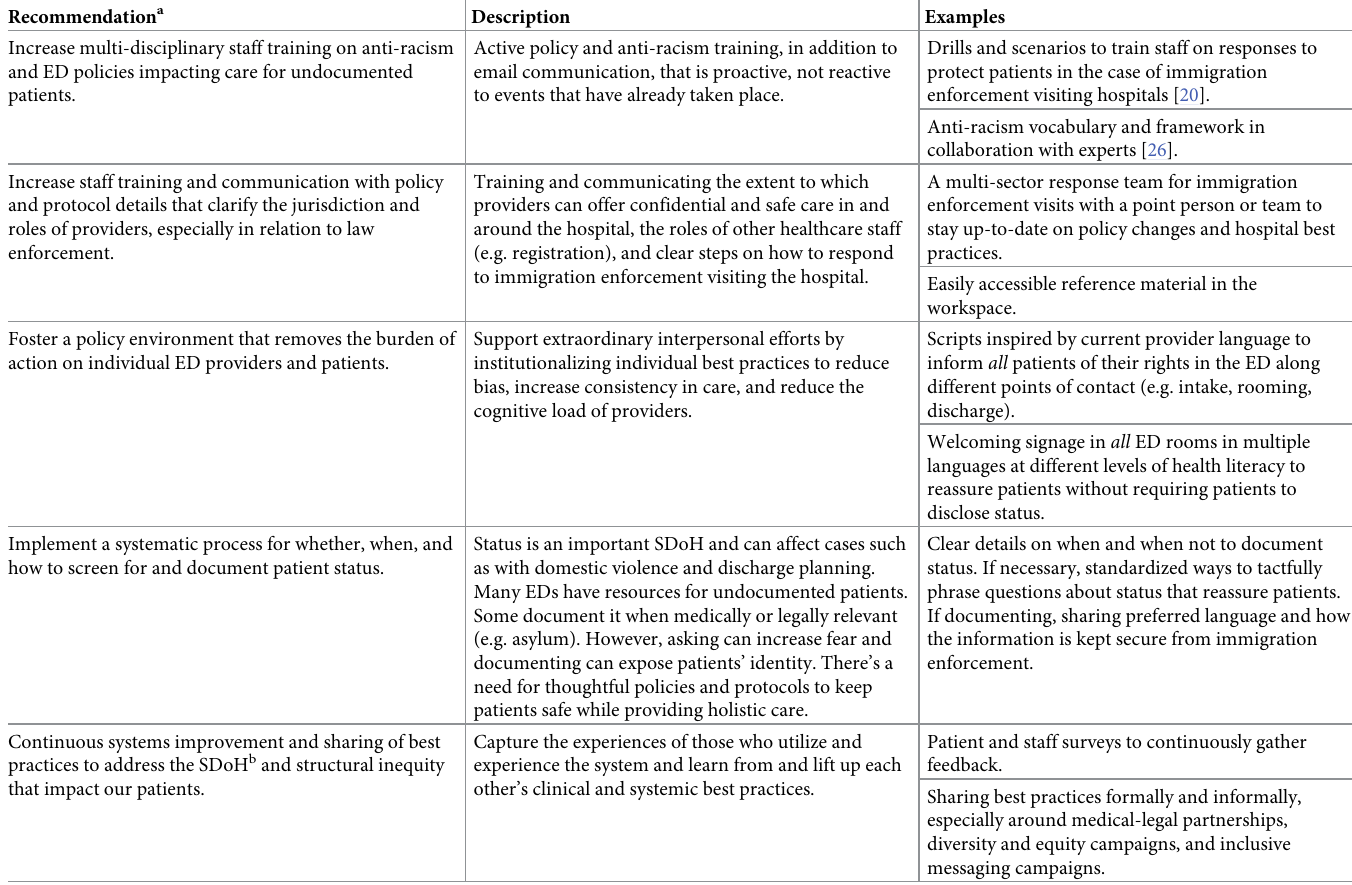
Table 1. Policy and protocol recommendations for Emergency Departments (EDs) caring for immigrant